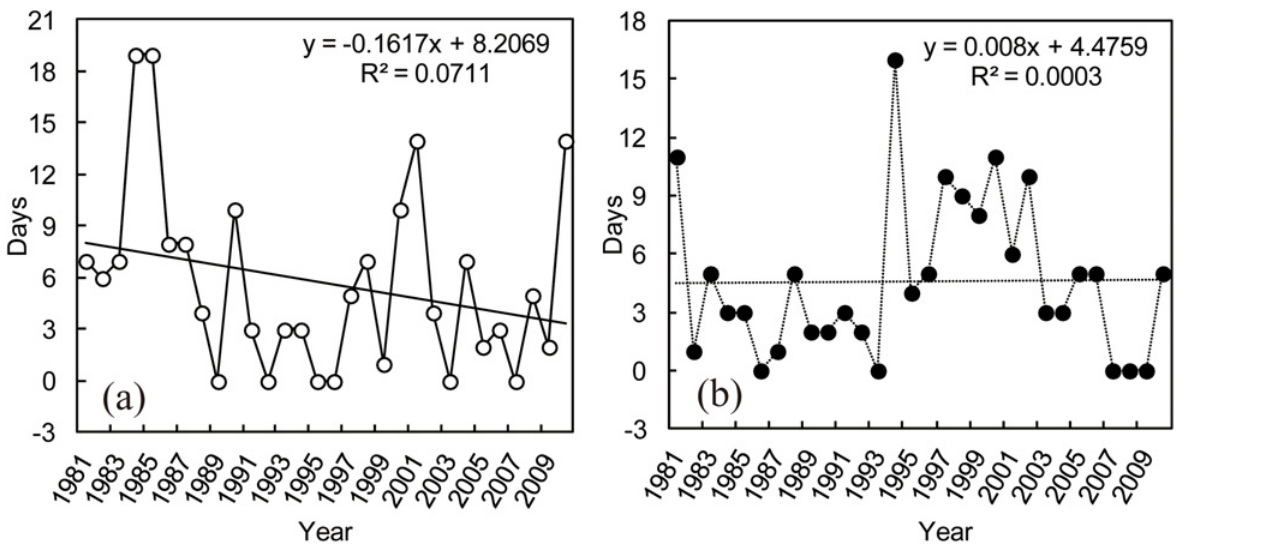
Fig 4. Yearly variations in days for extreme heating (a) and cooling (b) energy consumption of commercial building.